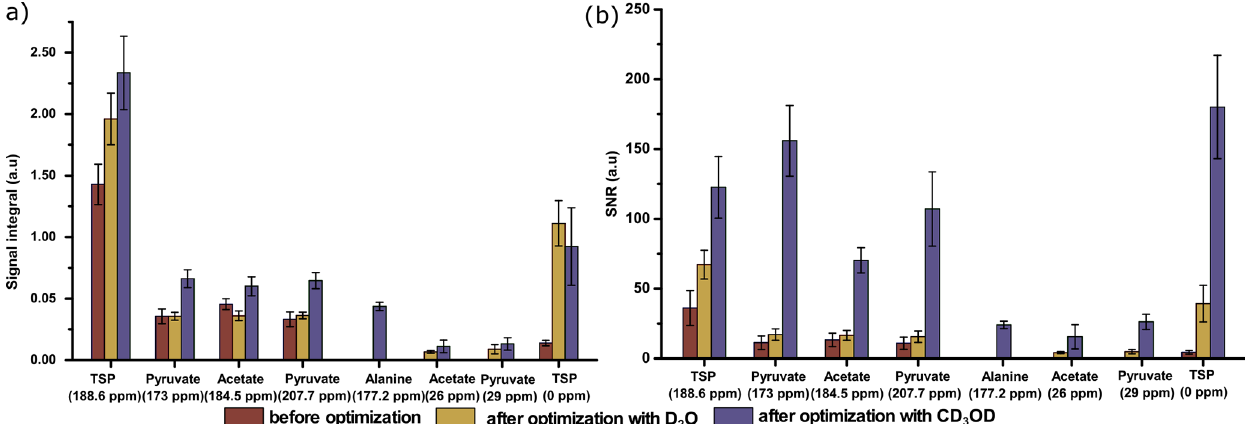
Figure 9. Comparison of 13 C– { 1 H } signals of metabolites with respect to (a) the average signal integral and (b) the average sensitivity along with the standard deviation, with and without systematically optimized parameters using two dissolution